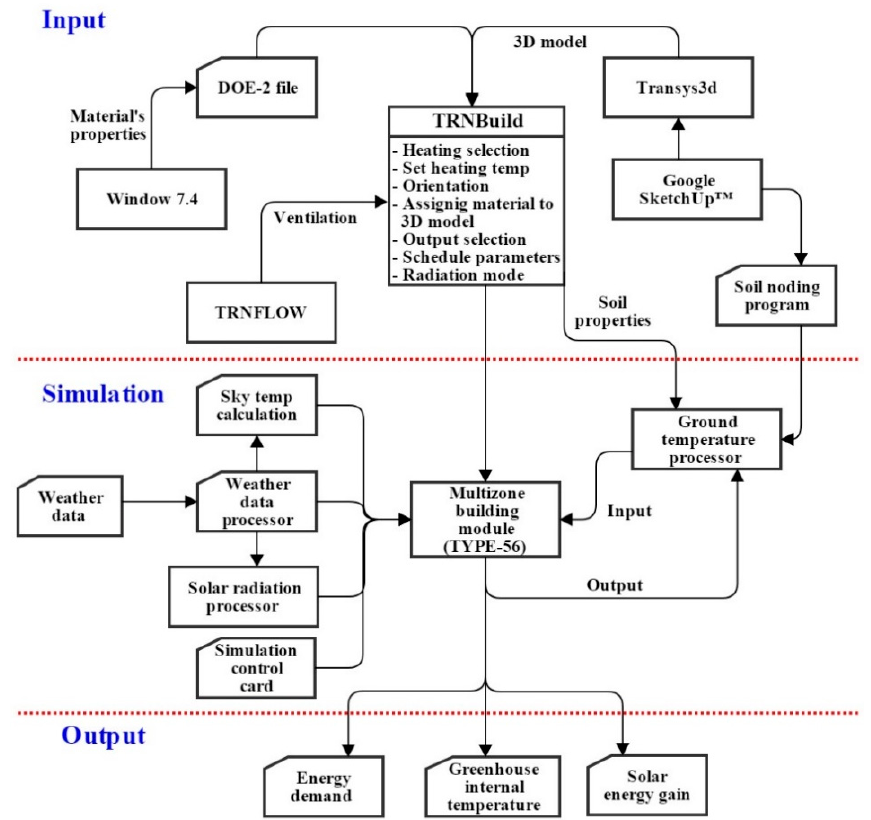
Figure 5. Flow chart of the modeling process.